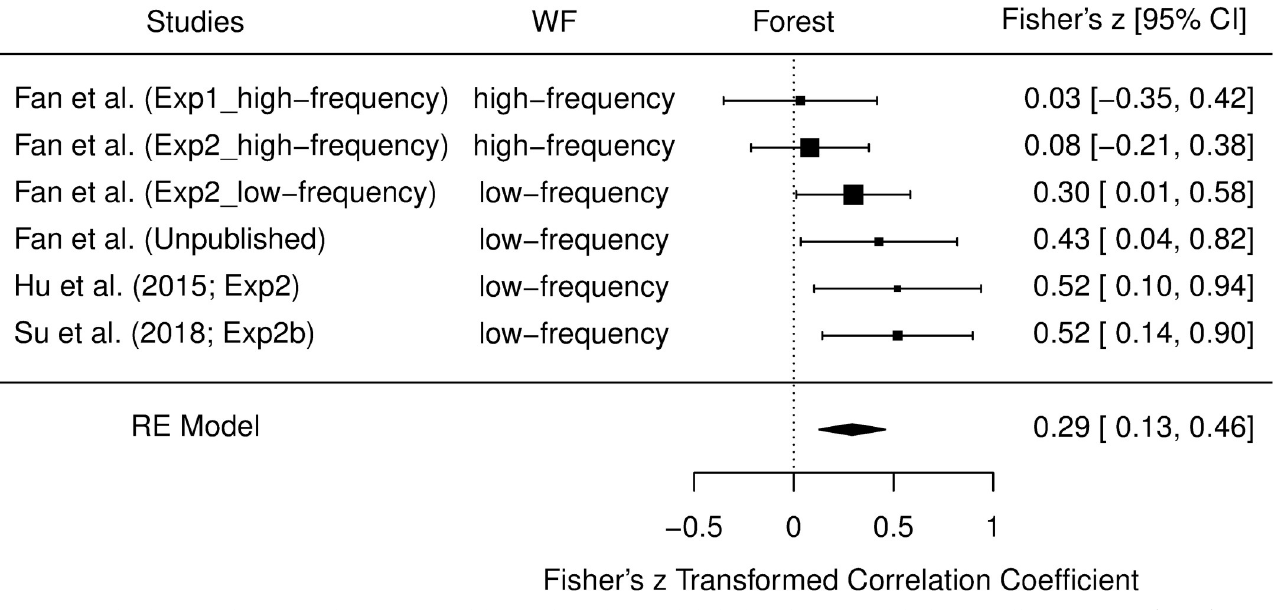
PLOS ONE | https://doi.org/10.1371/journal.pone.0257547 September 20,